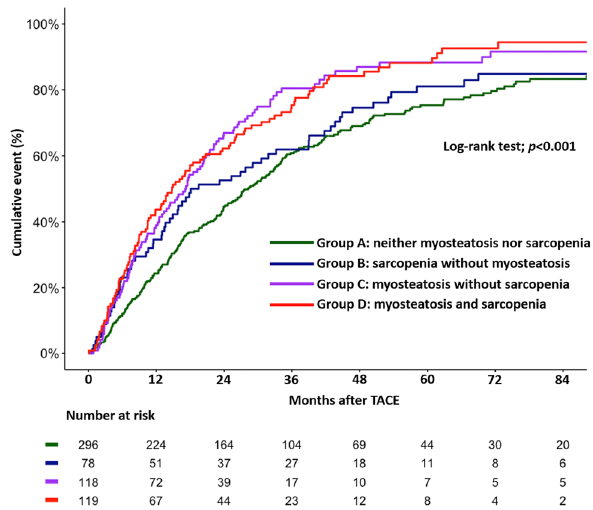
Figure 4. All-cause mortality according to myosteatosis and sarcopenia